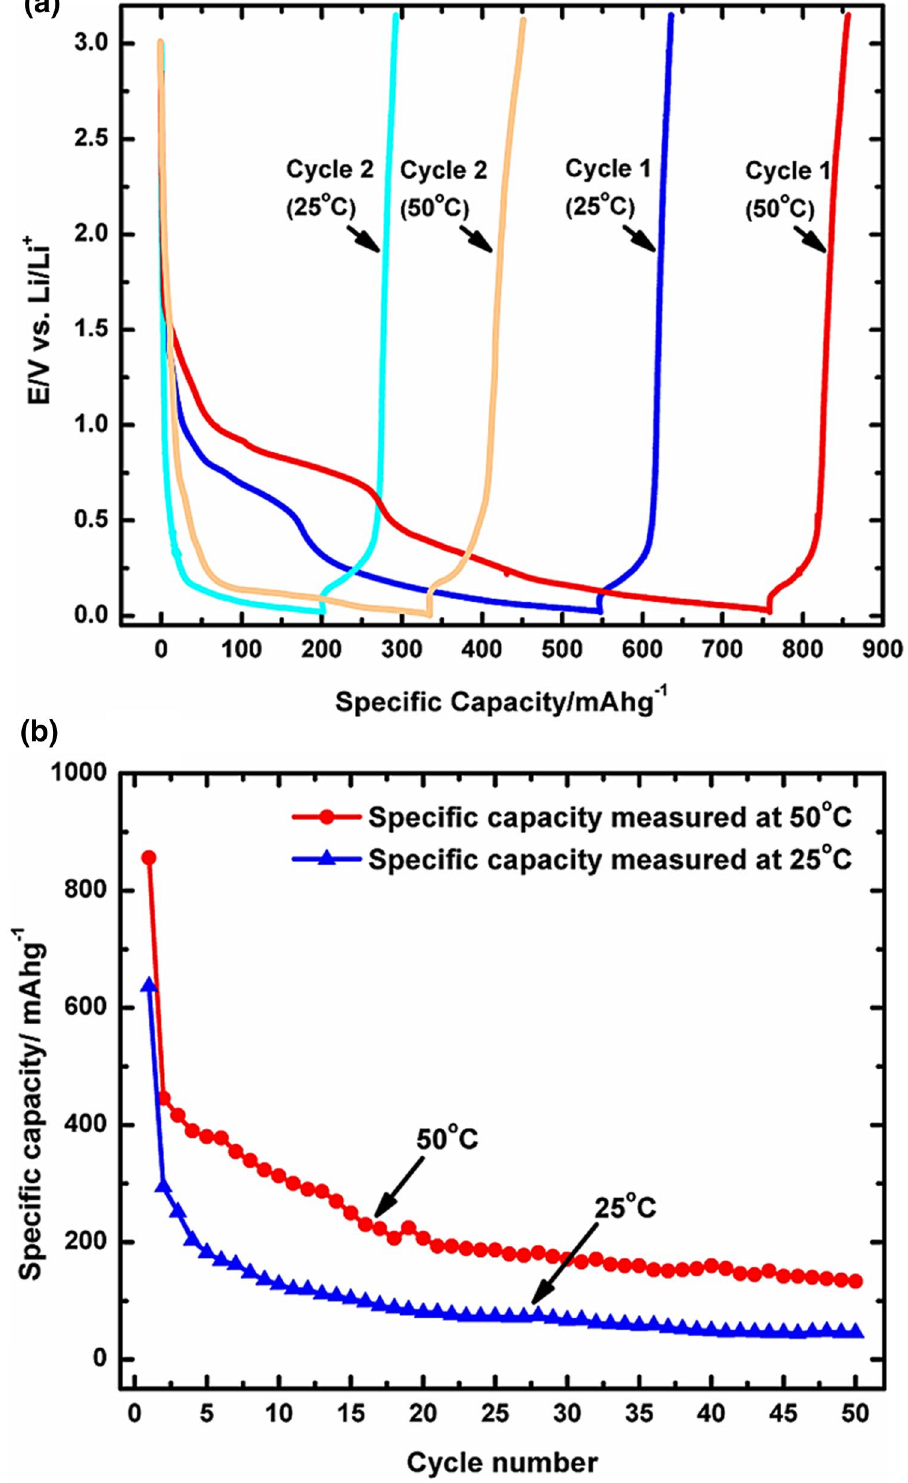
Fig. 4 a Charge/discharge profiles obtained during cycling of graphene nanoflake-based anodes at 25 and 50 °C and b specific capacities of graphene flakes at 25 and 50 °C using a charge/discharge rate of 0.04 Ag